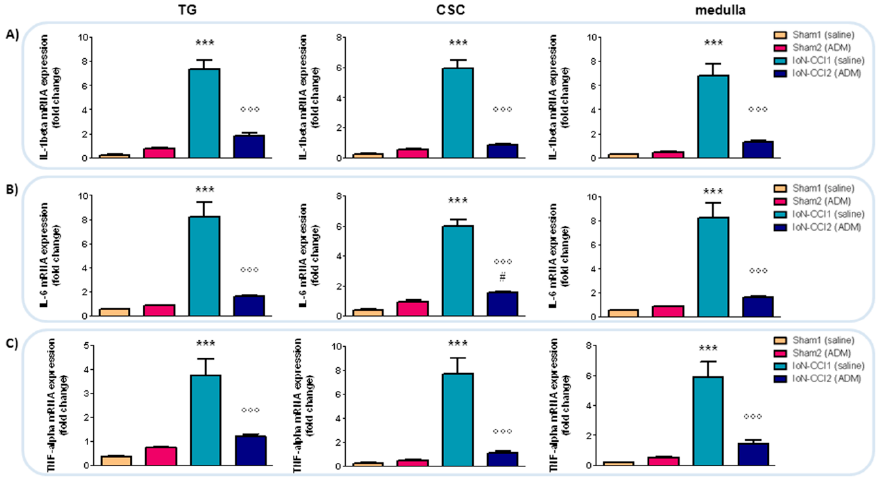
Figure 6. mRNA expression of IL-1beta ( A ), IL-6 ( B ), and TNF-alpha ( C ) in ipsilateral TG and CSC, and in medulla in toto. Data are expressed as mean + SEM. One way analysis of variance (ANOVA) followed by Tukey’s Multiple Comparison Test, *** p < 0.001 vs. Sham1 and Sham2, °°° p < 0.001 vs. IoN-CCI1, # p < 0.05 vs. Sham1.